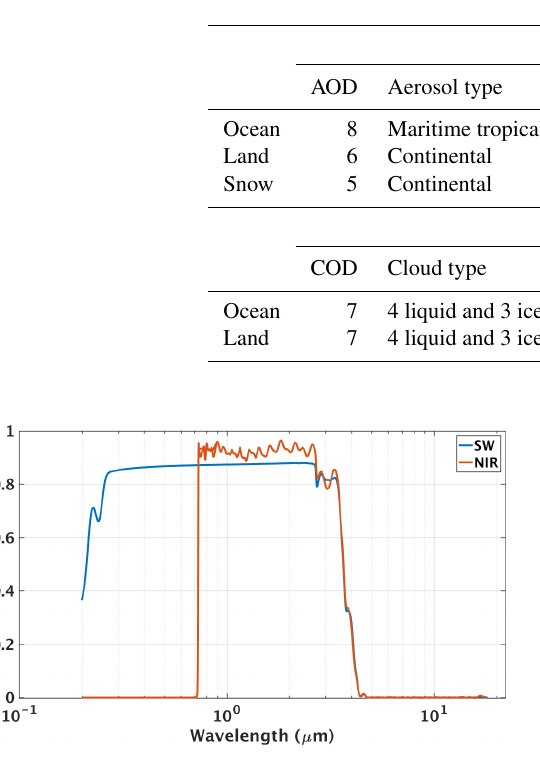
Figure 2. NISTAR SW and NIR spectral transmission